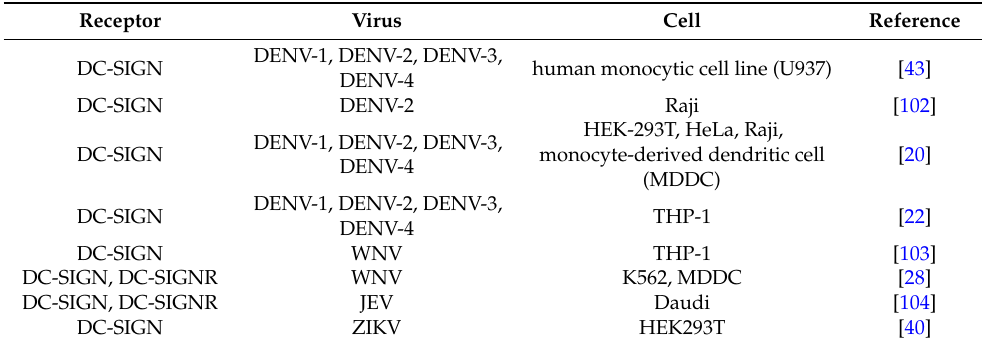
Table 1. Dendritic cell-specific intercellular adhesion molecule-grabbing nonintegrin (DC-SIGN) are involved in receptor mediated host cell entry of many pathogenic